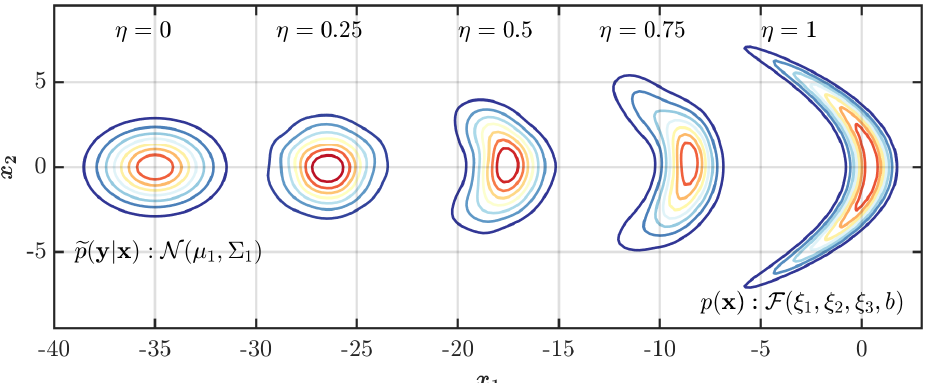
Figure 1. The analysis distribution obtained as a Wasserstein barycenter for different values of the displacement parameter η ∈ [ 0 , 1 ] between a background distribution represented by a banana-shaped distribution p( x ) : F (ξ 1 ,ξ 2 ,ξ 3 ,b) with ξ 1 = 0 . 02, ξ 2 = 0 . 06, ξ 3 = 1 . 6, and b = 8 and the normalized likelihood function represented by a bivariate Gaussian (cid:101) p( y | x ) : N ( µ 1 , (cid:54) 1 ) , where µ 1 =